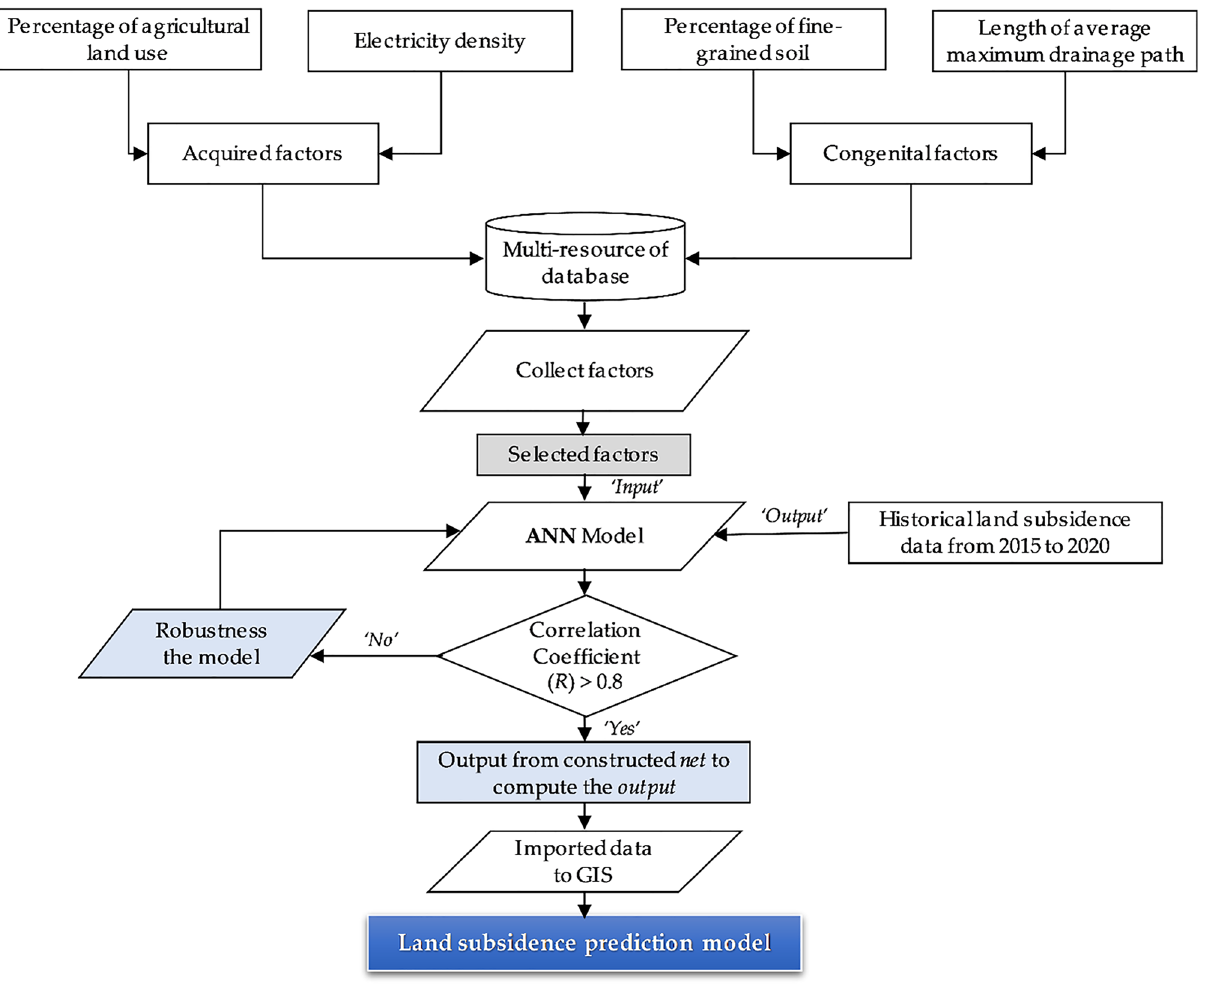
Figure 9. Flowchart of the proposed